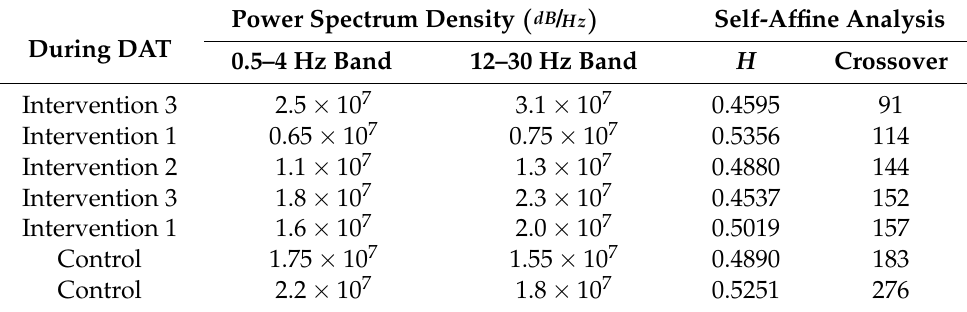
Table 2. Summary of the experimental results from Experimentation. Power Spectrum Density ( dB / Hz ) Self-Affine During DAT